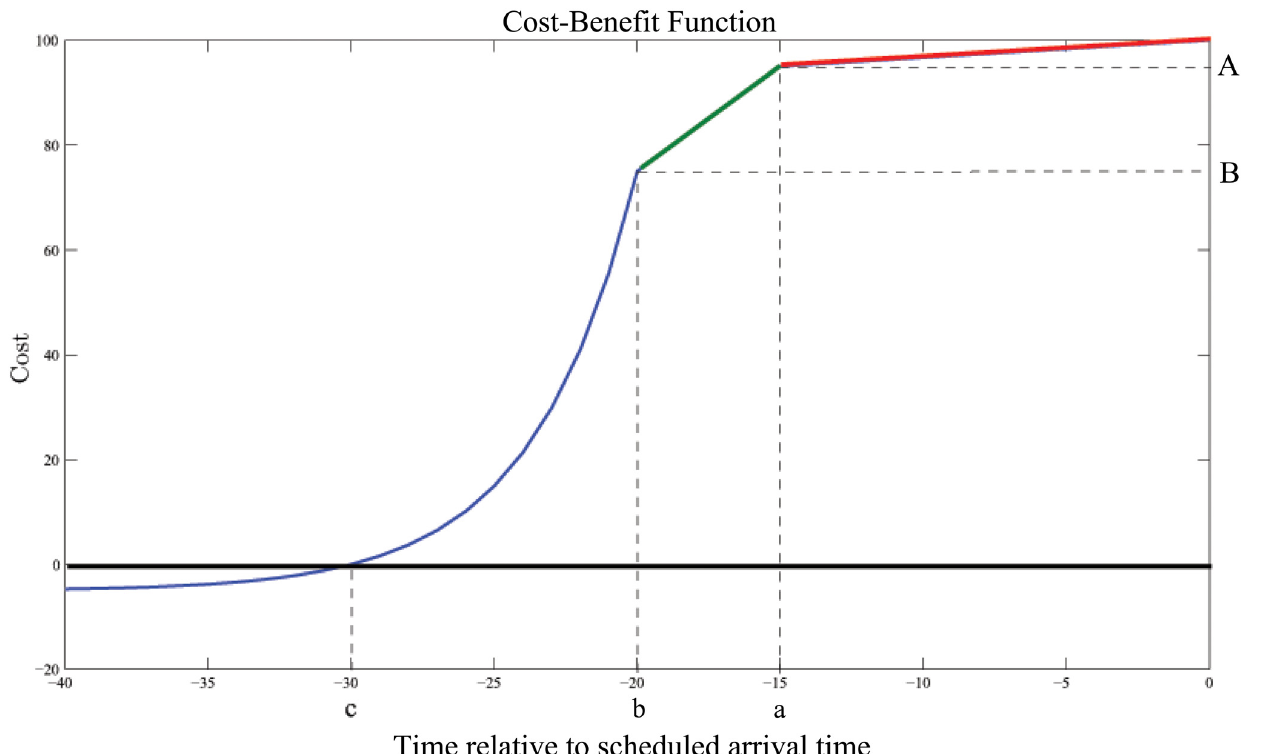
Fig 2. The Cost-Benefit Curve for Scenario